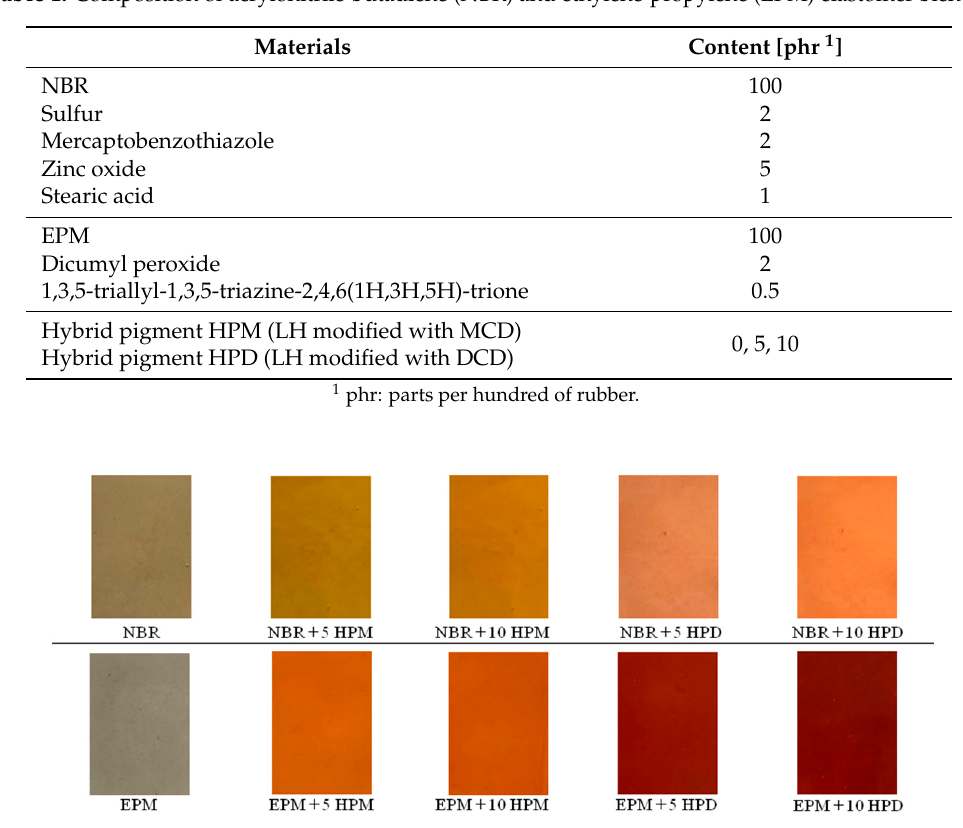
Table 1. Composition of acrylonitrile-butadiene (NBR) and ethylene-propylene (EPM) elastomer blends.